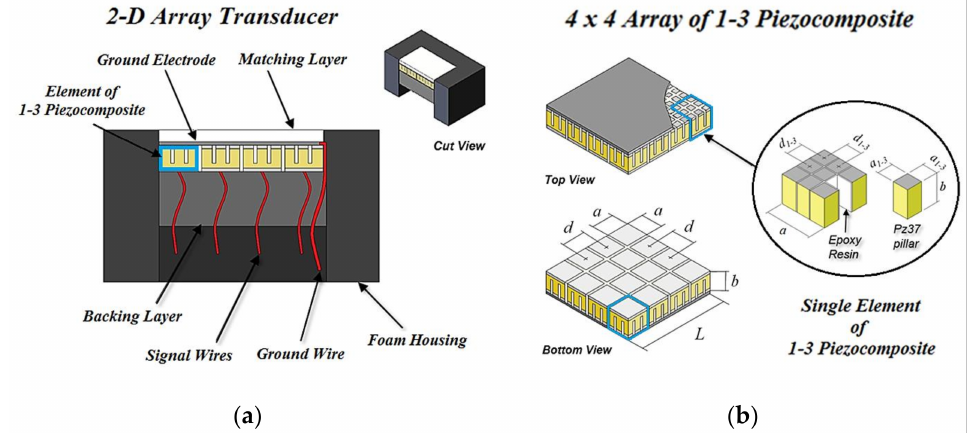
Figure 1. ( a ) Overview of the 2-D array ultrasonic transducer prototype; ( b ) Dimensions of the array made of 1–3 piezocomposite: a = 5 mm, a 1–3 = 1.53 mm, d = 5.2 mm, d 1–3 = 1.73 mm, b = 2.8 mm, L = 20.6 mm (a single element is outlined in